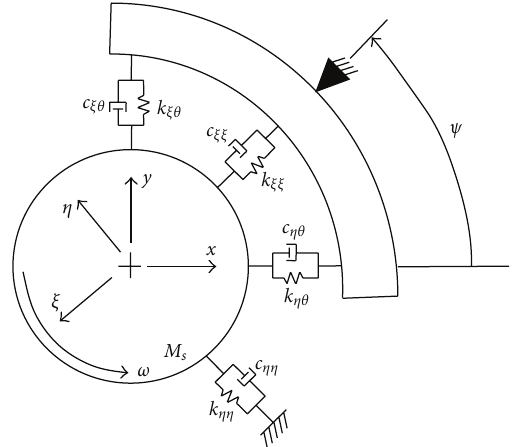
Figure 4: Free body diagram, dhaft translational degrees of freedom, and rigid pivots.